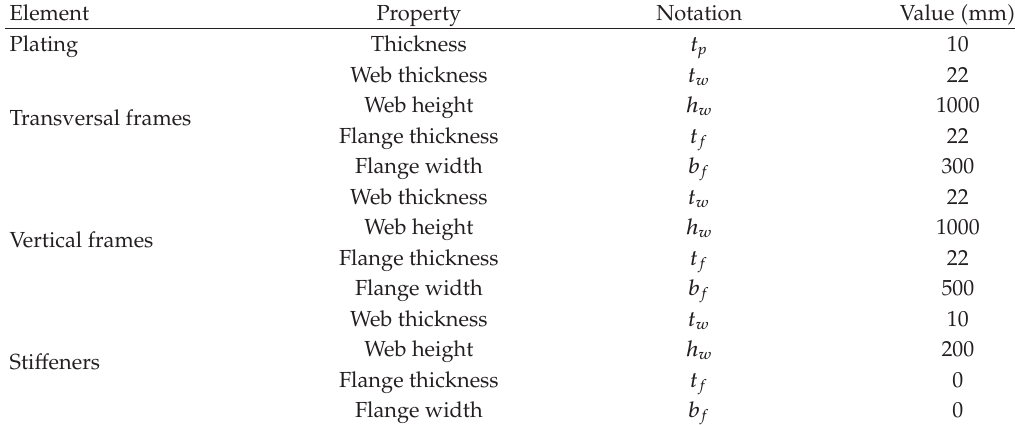
Table 3: Geometrical data defining gate